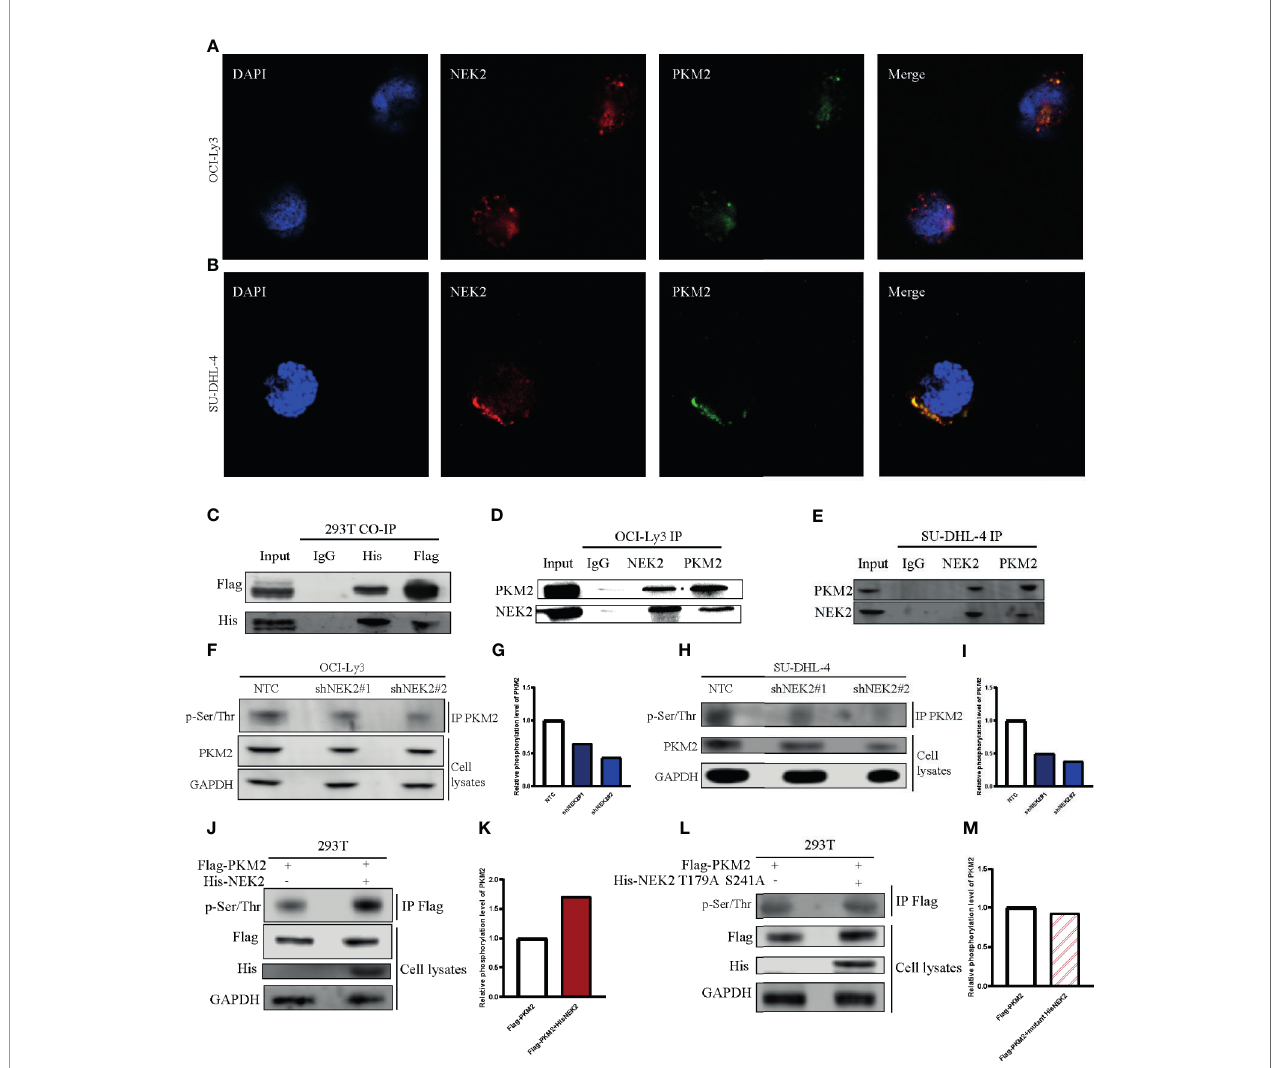
FIGURE 4 | NEK2 bound to PKM2 an increases PKM2 phosphorylation in DLBCL cells. (A, B) The immuno fl uorescent staining of nuclei (blue), NEK2 (red) and PKM2 (green) in OCI-Ly3 and SU-DHL-4 cells; (C) The interplay between NEK2 and PKM2 was successfully detected by Co-IP; (D, E) The endogenous interaction between NEK2 and PKM2 proteins in OCI-Ly3 and SU-DHL-4 cells was analyzed by IP; (F – I) After infection with Non-target control (NTC) shRNA or NEK2 shRNA lentiviral vector, PKM2 Ser/Thr phosphorylation in OCI-Ly3 and SU-DHL-4 cells were examined by representative IP experiments and quanti fi cation of relative PKM2 phosphorylation level were shown in box plots. Knockdown of NEK2 decreased PKM2 Ser/Thr phosphorylation in SU-DHL-4 cells; (J, K) 293T cells were co- transfected with His-tagged NEK2 vector or control vector as well as Flag-tagged PKM2 vector. PKM2 Ser/Thr phosphorylation was examined by representative IP experiments, and quanti fi cation of relative PKM2 phosphorylation level was shown in a box plot. Phosphorylation of Flag-tagged PKM2 was increased by forced expression of His-tagged NEK2 in 293T cell; (L, M) 293T cells were co-transfected with empty vector or His-tagged NEK2 T179A S241A mutant (Threonine179 to alanine mutation and Serine241 to alanine mutation), along with Flag-tagged PKM2. Inactivated NEK2 failed to increase the phosphorylation of